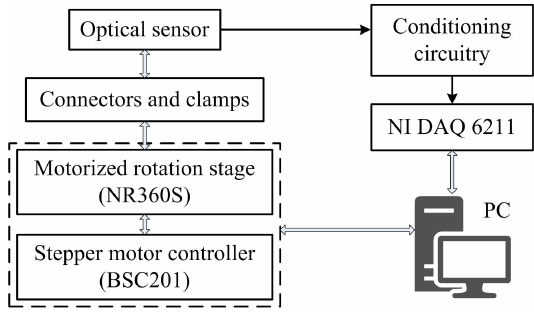
Figure 4. The block diagram of the automated measurement